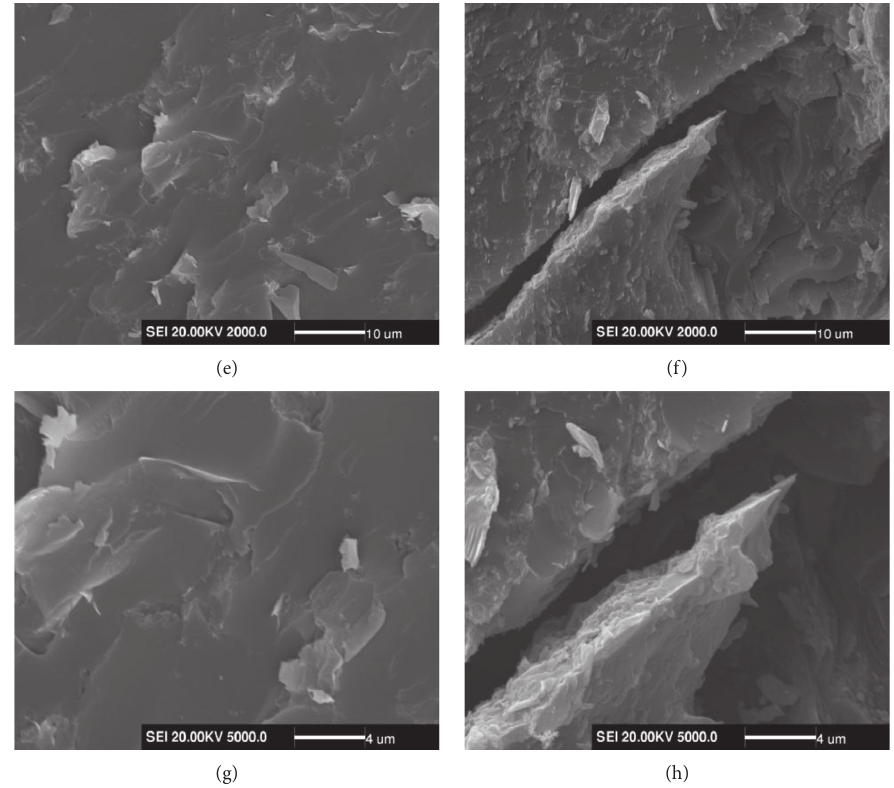
Figure 10: Scanning electron micrograph of coal body before and after loading. (a) Before loading100 (100 times). (b) After loading (100 times). (c) Before loading (500 times). (d) After loading (500 times). (e) Before loading (2000 times). (f) After loading (2000 times). (g) Before loading (5000 times). (h) After loading (5000 times).